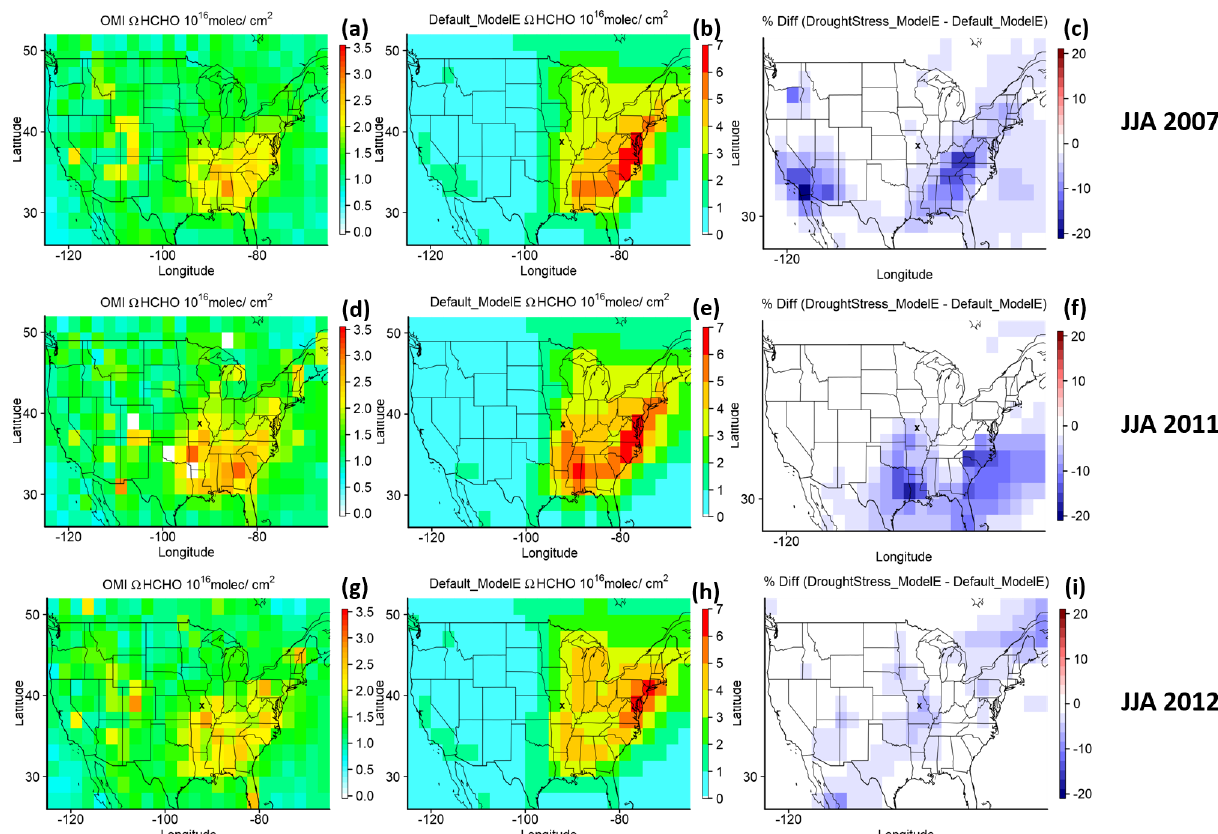
Figure 6. The (cid:127) HCHO column (units: molec.cm − 2 ) for OMI, Default_ModelE, and the percent difference between DroughtStress_ModelE and Default_ModelE across the US during the summer of drought years 2007, 2011, and 2012. X indicates the location of the MOFLUX site on the spatial